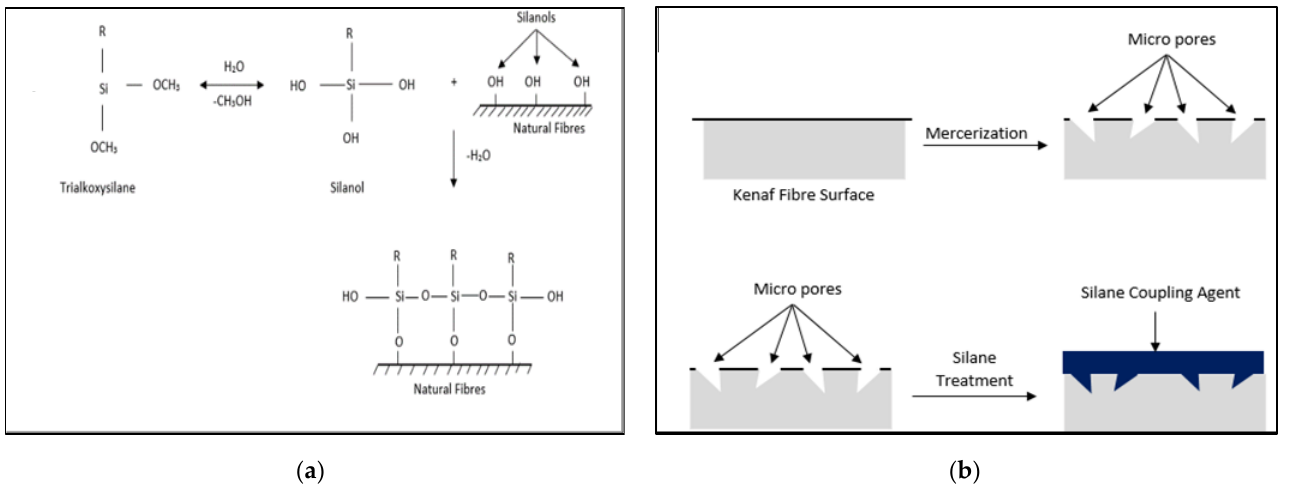
Figure 7. The overview reaction of surface modification ( a ) Silane reaction; ( b ) Mercerisation and silane treatment process.